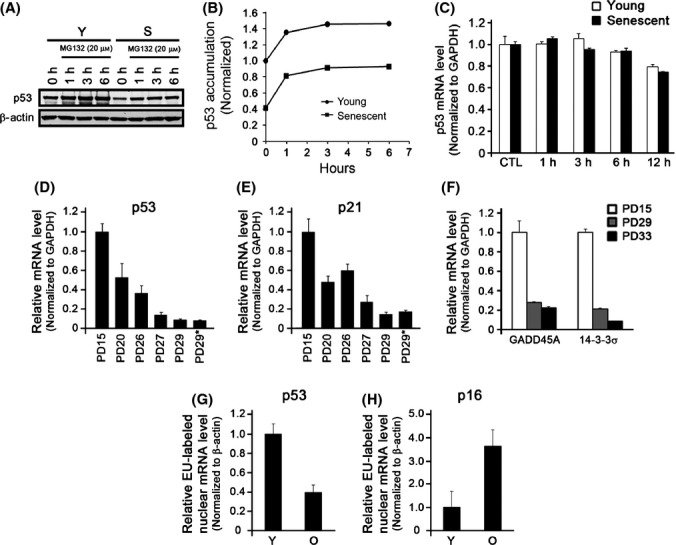
p53 is regulated at the transcriptional level. (A) Young and senescent normal human keratinocytes (NHKs) were treated with MG132 (20 μm) for 0, 1, 3, and 6 h. Cells were harvested and Western blotting was performed against p53 and β-Actin. (B) The densitometry analysis of (A) was performed to quantitate the amount of p53 using Image J. (C) Young and senescent NHKs were treated with Actinomycin D (2 μm) for 0, 1, 3, 6, and 12 h. Cells were harvested and qRT–PCR was performed for p53 expression. The expression of p53 mRNA for both young and senescent NHKs was normalized to those in untreated cells. The primary NHKs were serially subcultured until they senesced, and NHKs at the different PDs were subjected to qRT–PCR for the expressions of p53 (D) and p21 (E). GAPDH was used as a control. (F) The direct p53 target genes, GADD45A, and 14-3-3σ were evaluated using qRT–PCR. Newly synthesizing nascent p53 (G) and p16 (H) nuclear mRNAs were detected using Click-iT Nascent RNA Capture kit followed by qRT–PCR.